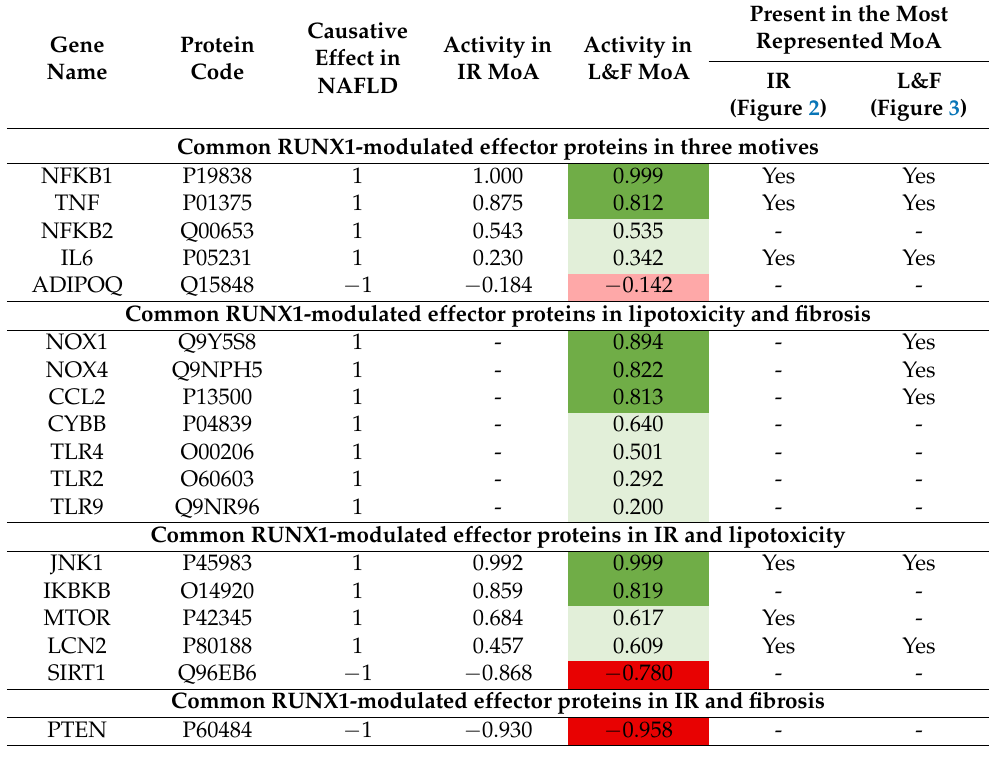
Table 4. Effector proteins modulated by RUNX1 activation shared by the three motives: lipotoxicity and fibrosis; IR and lipotoxicity; and IR and